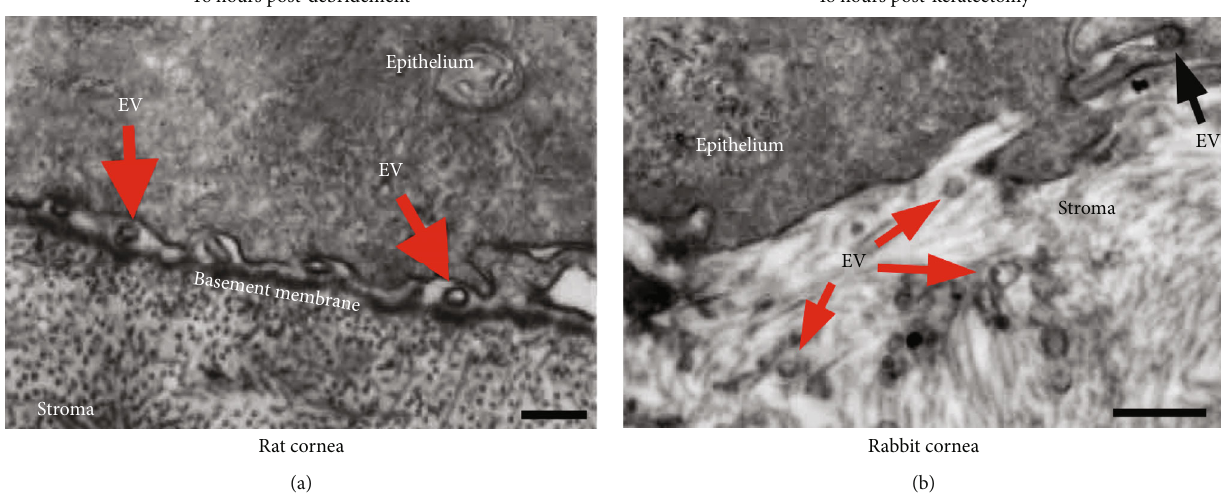
Figure 5: TEM images of the epithelial-stromal interface in the corneas with varying severity of wounds: (a) debridement (basement membrane left intact) and (b) keratectomy (basement membrane removed). (a) Localization of EVs ( red arrows ) on the anterior side of the epithelial basement membrane in a rat cornea at 18 hours postdebridement. Scale bar = 250 nm . (b) Dispersion of EVs ( red arrows ) in the anterior stroma in a rabbit cornea at 48 hours postkeratectomy. EV undergoing endocytosis/exocytosis ( black arrow ). Scale bar = 250 nm . Images were modi fi ed and reproduced from Han et al. 2017 [64] based on a Creative Commons license (CC BY 4.0), doi:10.1038/